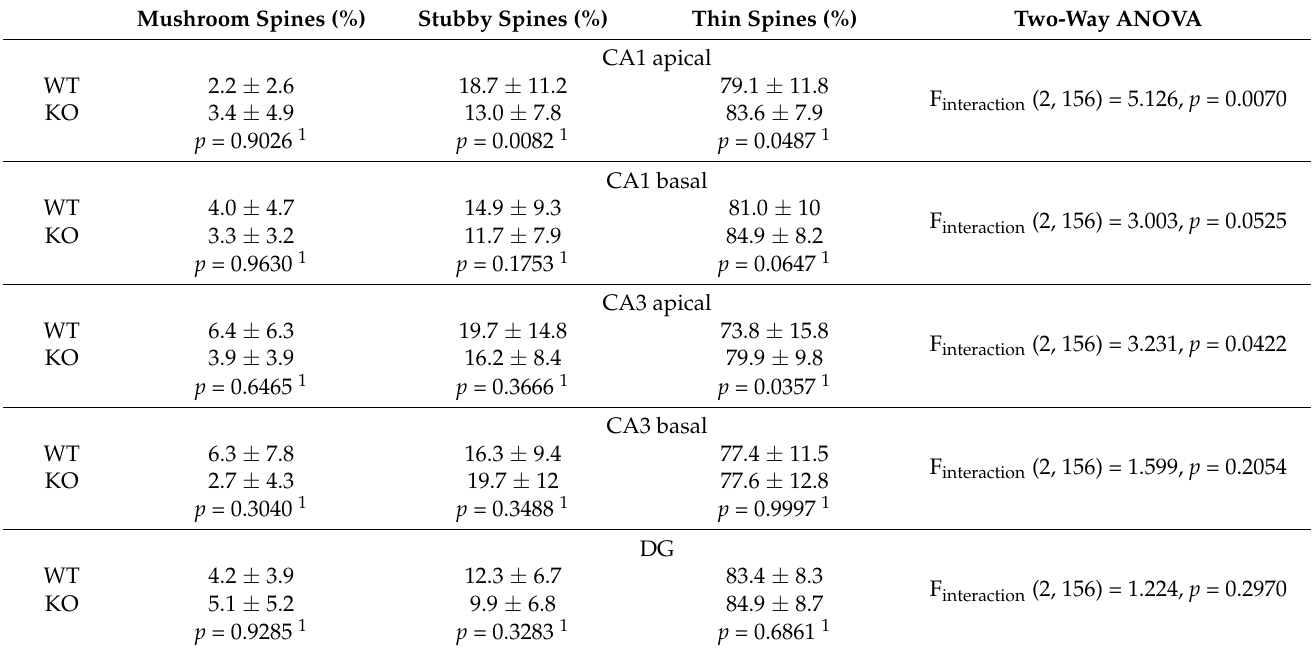
Table 4. Results of two-way ANOVA tests for the effects of genotype and spine morphology on the proportion of dendritic spines in each hippocampal subregion of WT and KO mice ( n = 40 dendritic segments (10 µ m)/group). Mushroom Spines